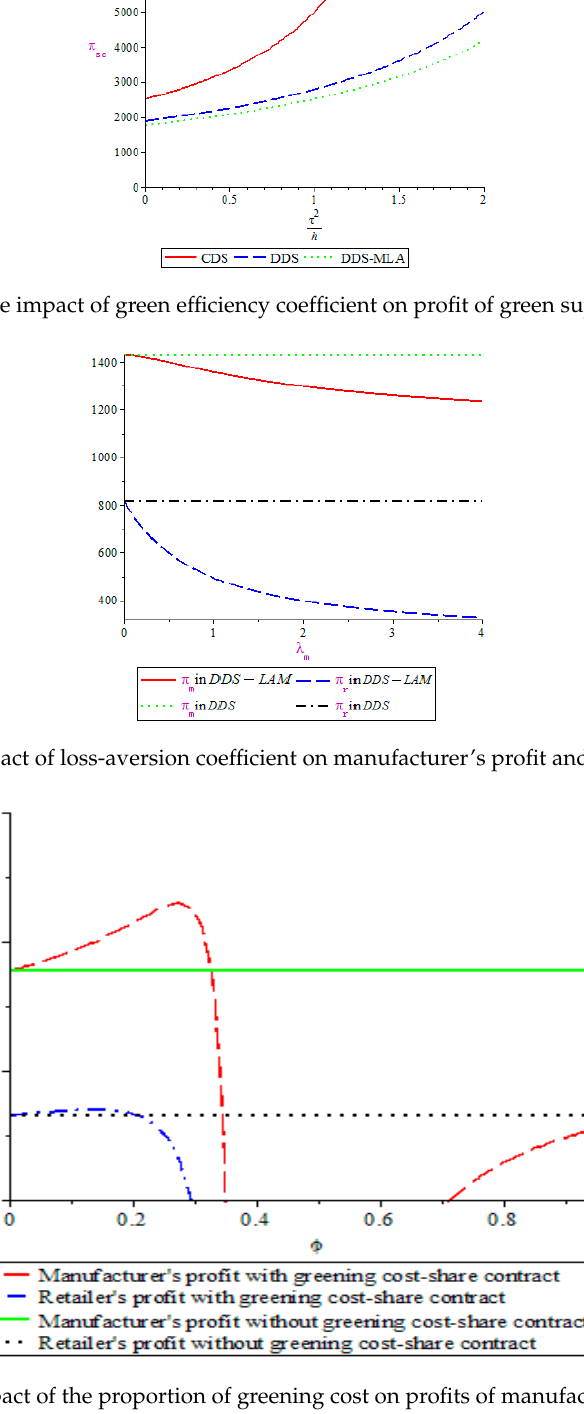
Figure 10. The impact of the proportion of greening cost on profits of manufacturer and retailer. 6. Summary 6.1. Managerial Insights This study can be applied to the green supply chain where the manufacturer occupies an absolute dominant position in the green supply chain. For example, the mobile phone industry supply chain includes HUAWEI, APPLE, and SAMSUNG. The model constructed in this paper helps non-rational decision-makers to make the optimal decisions in the green supply chains. In particular, in this paper, the model helps the loss-aversion manufacturer to make the optimal wholesale price decision and the optimal green degree decision. In addition, the model helps the risk-neutral retailer to make the optimal retail price decision. Thus, our model is of important